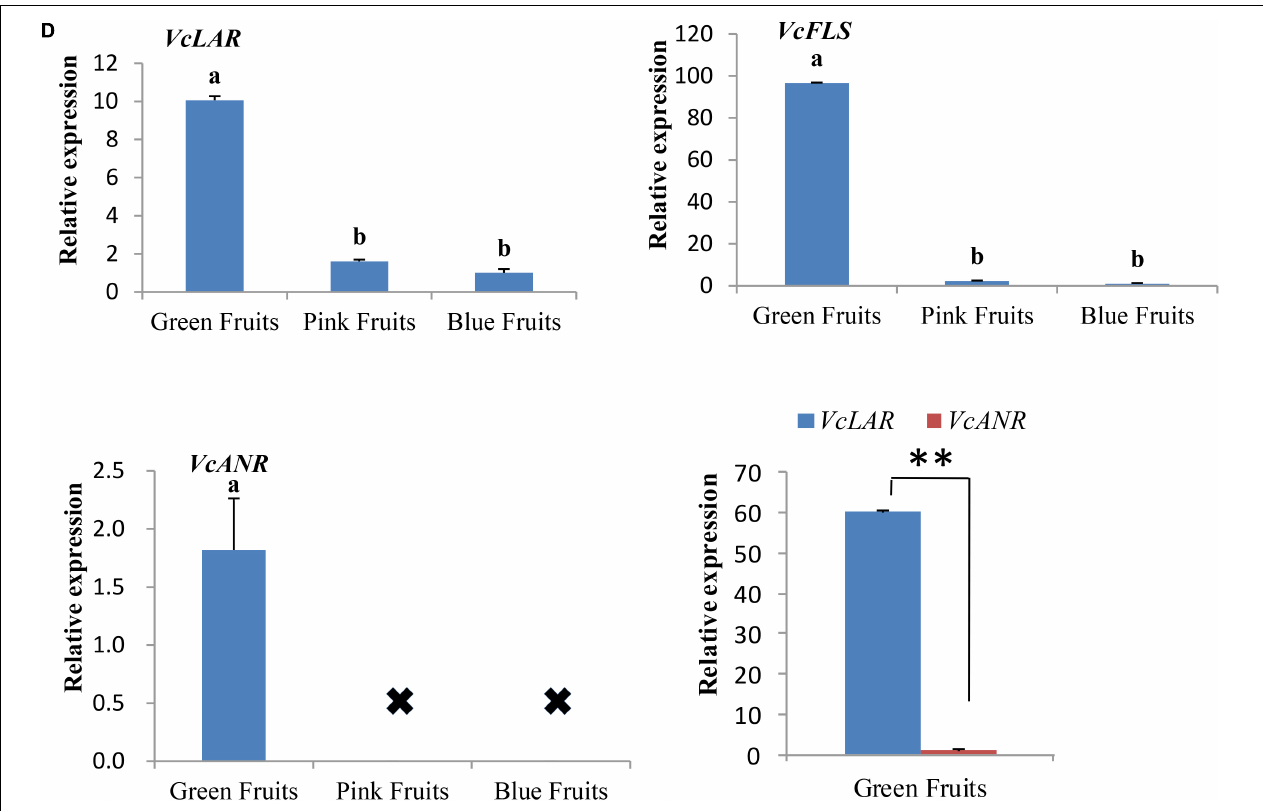
FIGURE 2 | Analysis of the expression of genes associated with flavonoid synthesis and accumulated flavonoids. (A) Liquid chromatography was used for quantitation of flavonoids content. Liquid chromatography-mass spectrometry was used for qualitative testing of flavonoids. Proanthocyanidin content at different developmental stages in blueberries. fwt, fresh weight. Asterisks denote t -test significance: ∗∗ P < 0.01. The mean ± SE of biological triplicates were taken for every value. (B–D) All values were calculated based on the geometric mean of the housekeeping genes, VcGADPH and VcSAND , at each stage. Asterisks denote t -test significance: ∗∗ P < 0.01. Different English letters represents that the one-way ANOVA difference was significant ( P < 0.05). The mean ± SE of biological triplicates were taken for every